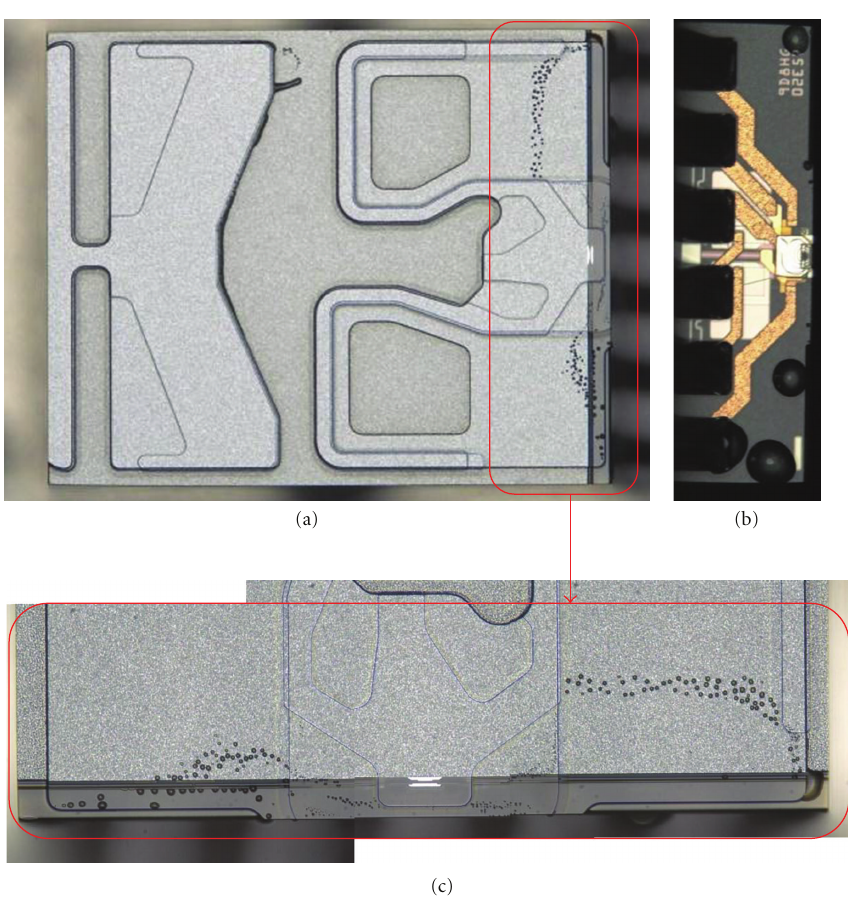
Figure 8: Optical microscope images (a) overall picture of ABS; (b) deposited ends of head; (c) enlarged picture of red square area in (a).